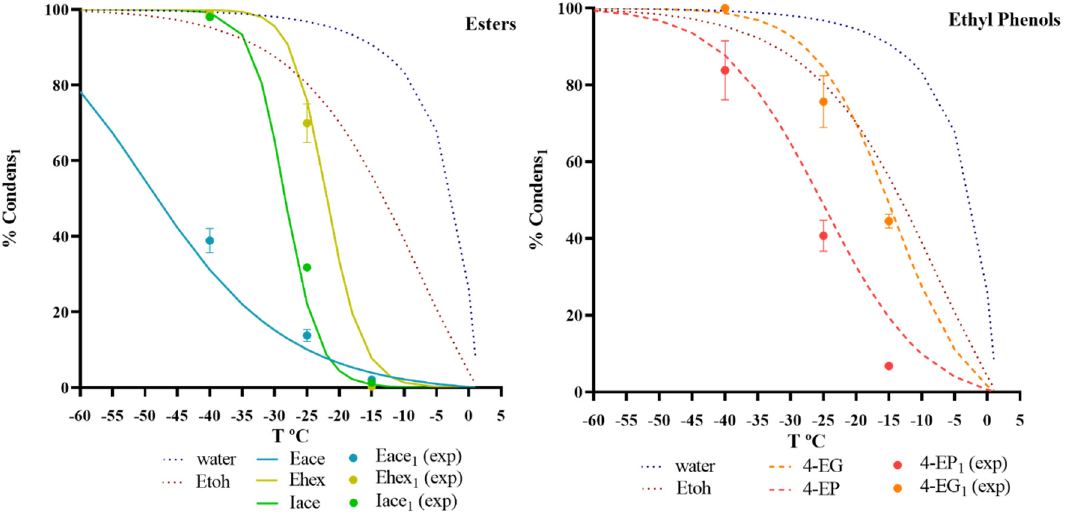
Figure 7. Validation of the model simulation for the different chemical families (esters and ethyl phenols) included in the red wine model solution. Percentage of condensation of each compound present (water, ethanol, ethyl acetate, ethyl hexanoate, isoamyl acetate, 4-ethyl phenol, and 4-ethyl guaiacol) in the 1st condenser ( %Condens i1 ). Operating conditions: Pervap 4060 membrane; T feed = 30 °C; p perm = 1000 Pa; The symbols represent the experimental values, whereas the lines show simulated data.